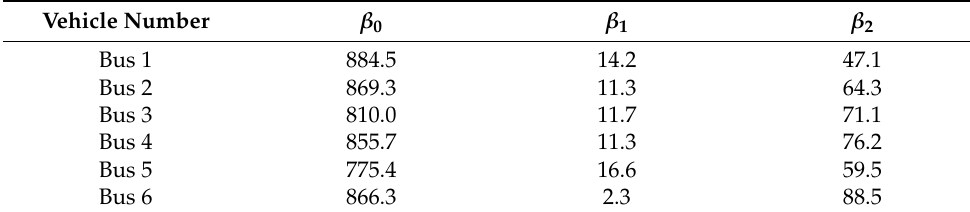
Table 2. Parameters of the physical model.